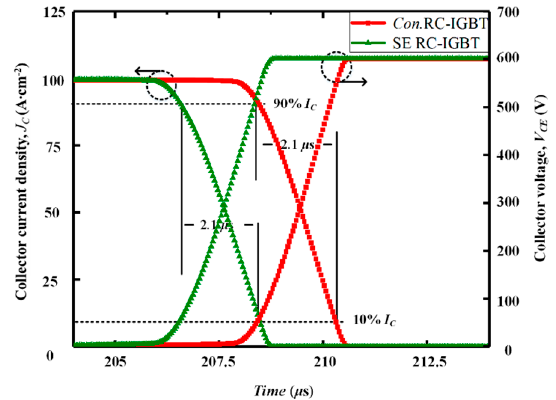
Figure 10. IGBT turn-off I-V characteristics of conventional RC-IGBT and SE RC-IGBT.